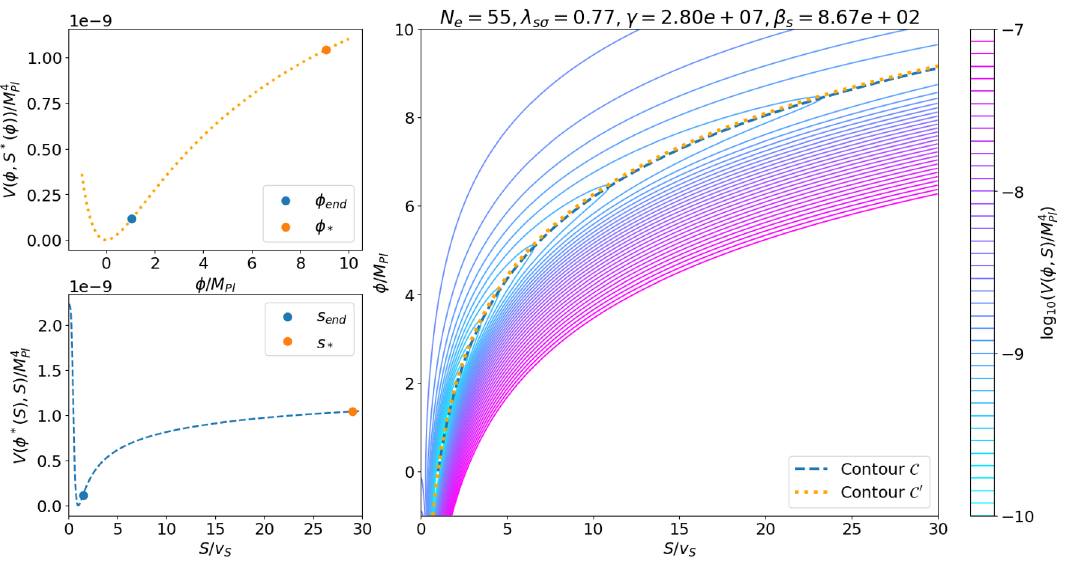
JHEP08(2021)016